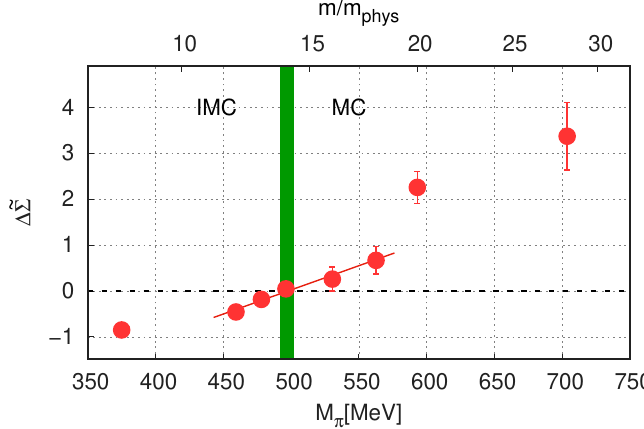
Figure 6 . The change in the condensate due to the magnetic (cid:12)eld eB 0 = 0 : 6 GeV 2 along the pseudo-critical trajectory in terms of the pion mass. The green vertical line indicates the limiting pion mass, which separates the IMC and MC